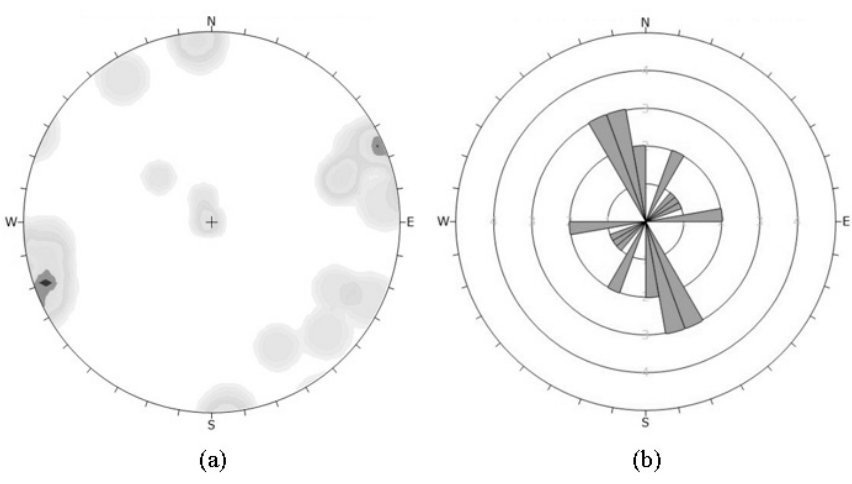
Figure 6. ( a ) Pole density plot—lower hemisphere, Schmidt equal area stereographic projection. ( b ) Rose diagram showing direction and count (total number) for the discontinuities measured (fractures and bedding planes).